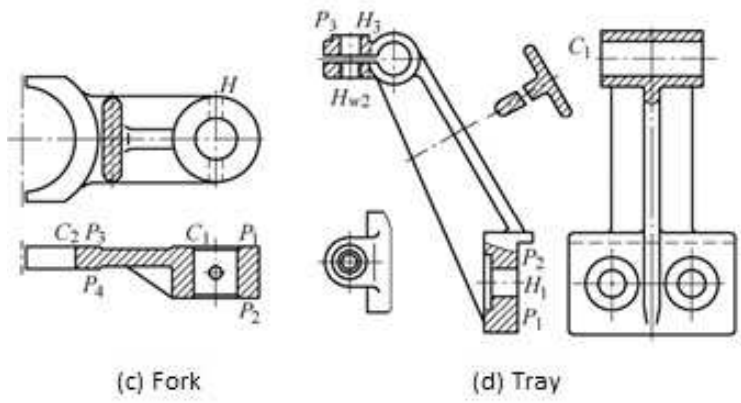
Figure 2. Expression views of several mechanical parts’ functional surfaces (2).